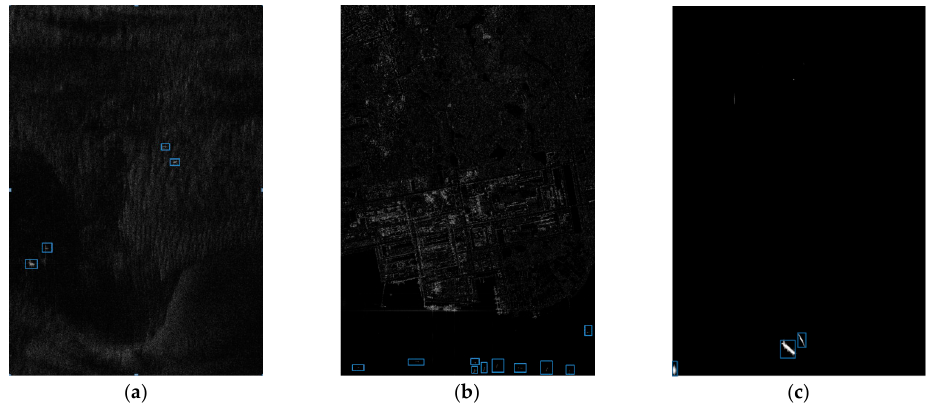
Figure 10. Results of the whole method on sub-images #1 to #3. ( a ) Result of sub-image #1; ( b ) Result of sub-image #2; ( c ) Result of sub-image #3.